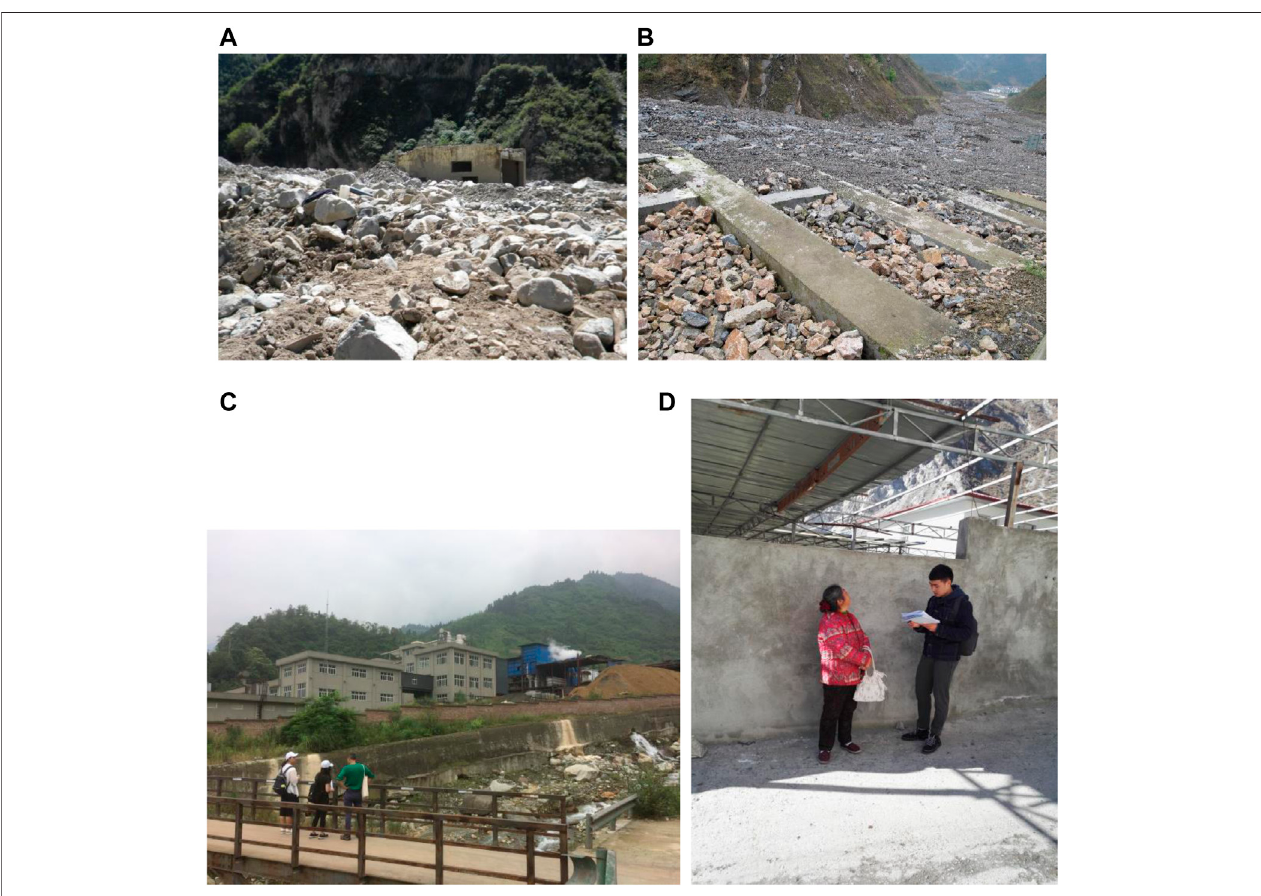
FIGURE3| Datacollectionprocess.[ (A) :ThelargemudslideinChenjiaba. (B) :ThelandslidepreventionactionsinChenjiaba. (C,D) :The fi eldresearch.]Note:Panel 3AisprovidedbyAssociateProfessorMingChang,StateKeyLaboratoryofGeohazardPreventionandGeoenvironmentProtection,ChengduUniversityofTechnology.